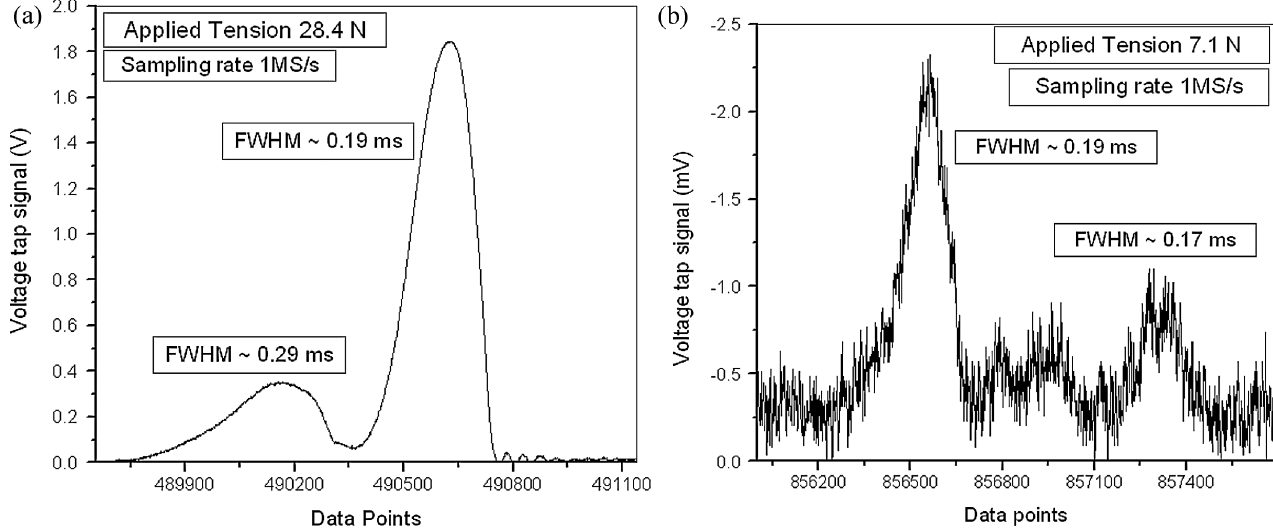
FIG. 8. (a) Voltage spike in the case of polyimide film. (b) Voltage spike in the case of Dyneema